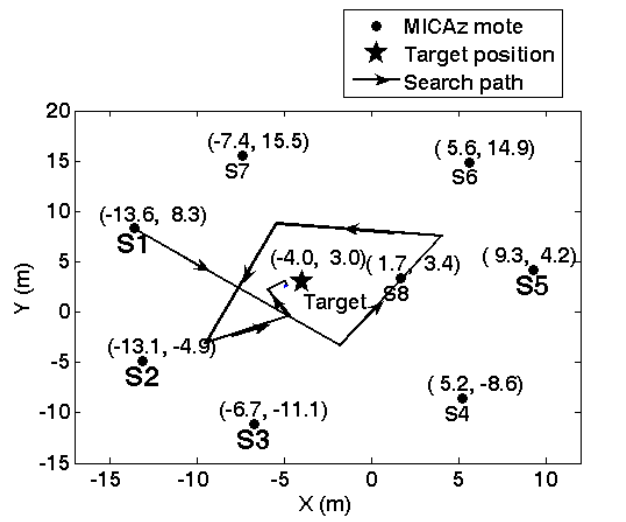
Figure 12. Vehicle localization by collaboration between s1, s2, s3 and s5.